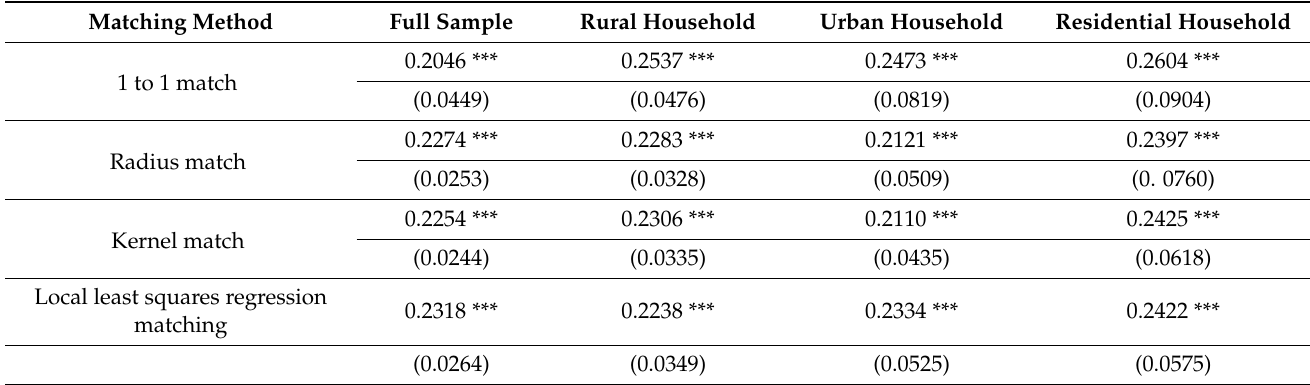
Table 5. PSM estimation results.